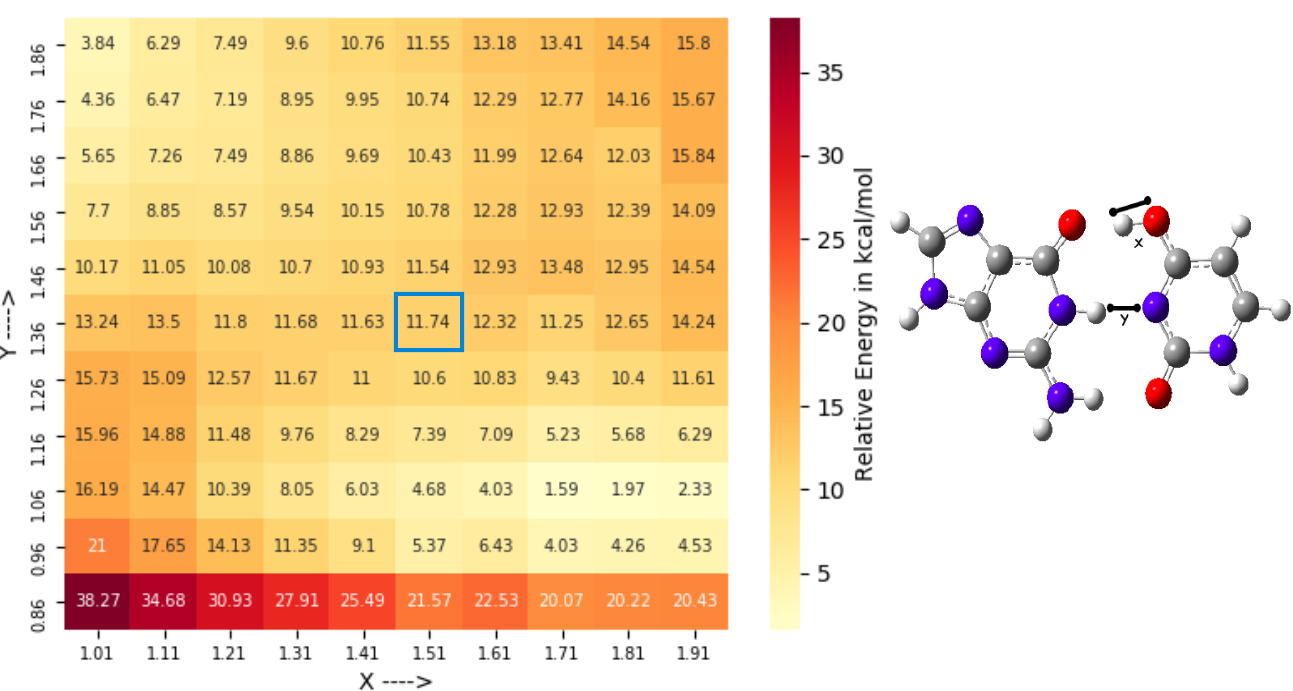
Figure 7. Reaction profile of the constrained TS search along the reaction coordinate X and Y highlighted in the balls and sticks representation of the G • U base pair for locating TS2 ‡ (6-31+G* basis sets used). Here, the QM-region consists of the G • U base pair along with two water molecules. The highlighted point was used for the TS optimization. Relative energies (kcal/mol) are calculated with respect to the wG • U base